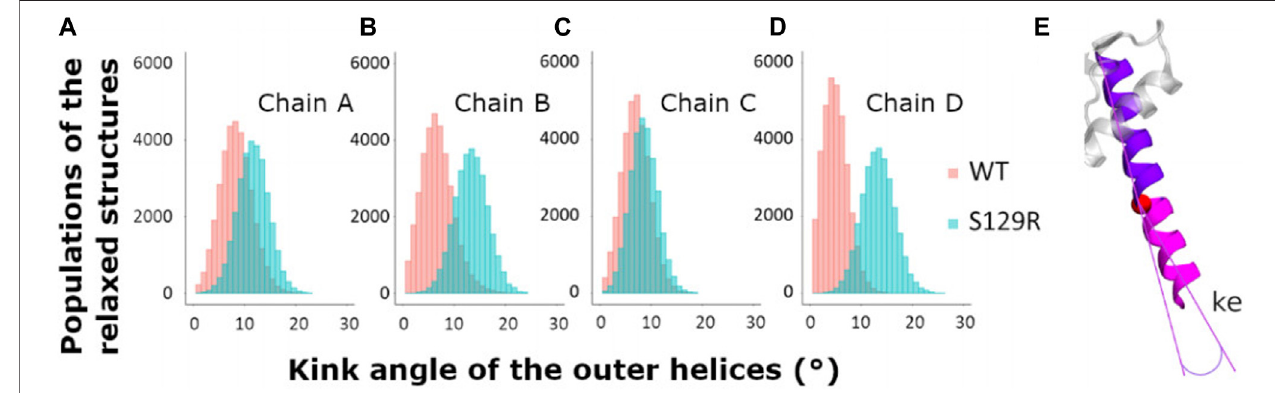
FIGURE 4 | Kink of the outer helices, TM1. Histograms of the values of the kink of the external helices during the relaxed simulations of molecular dynamics after MDeNM. The structures populations of KirBac3.1 WT are represented in red and the structures of KirBac3.1 S129R in blue (A) Kink of the outer helix of the chain A (B) Kink of the outer helix of the chain B (C) Kink of the outer helix of the chain C (D) Kink of the outer helix of the chain D (E) Representation of the outer kink angle